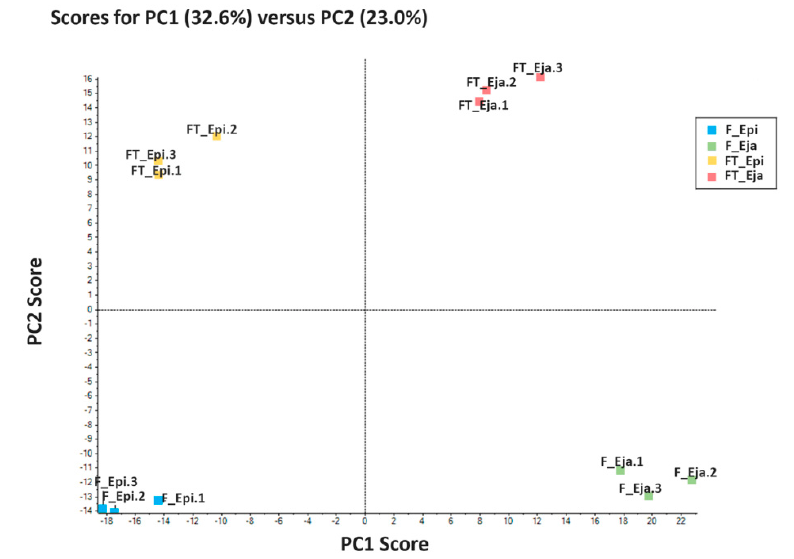
Figure 1. Two-dimensional principal component analysis (PCA) evaluating differences on the quantified proteins among sperm sources. PC1 discriminates between epididymal (Epi) and ejaculated (Eja) spermatozoa, whereas PC2 between fresh (F) and frozen-thawed (FT) spermatozoa. The squares represent the three technical replicates for each sperm source, based on the relative amounts of protein quantified in each one of them.